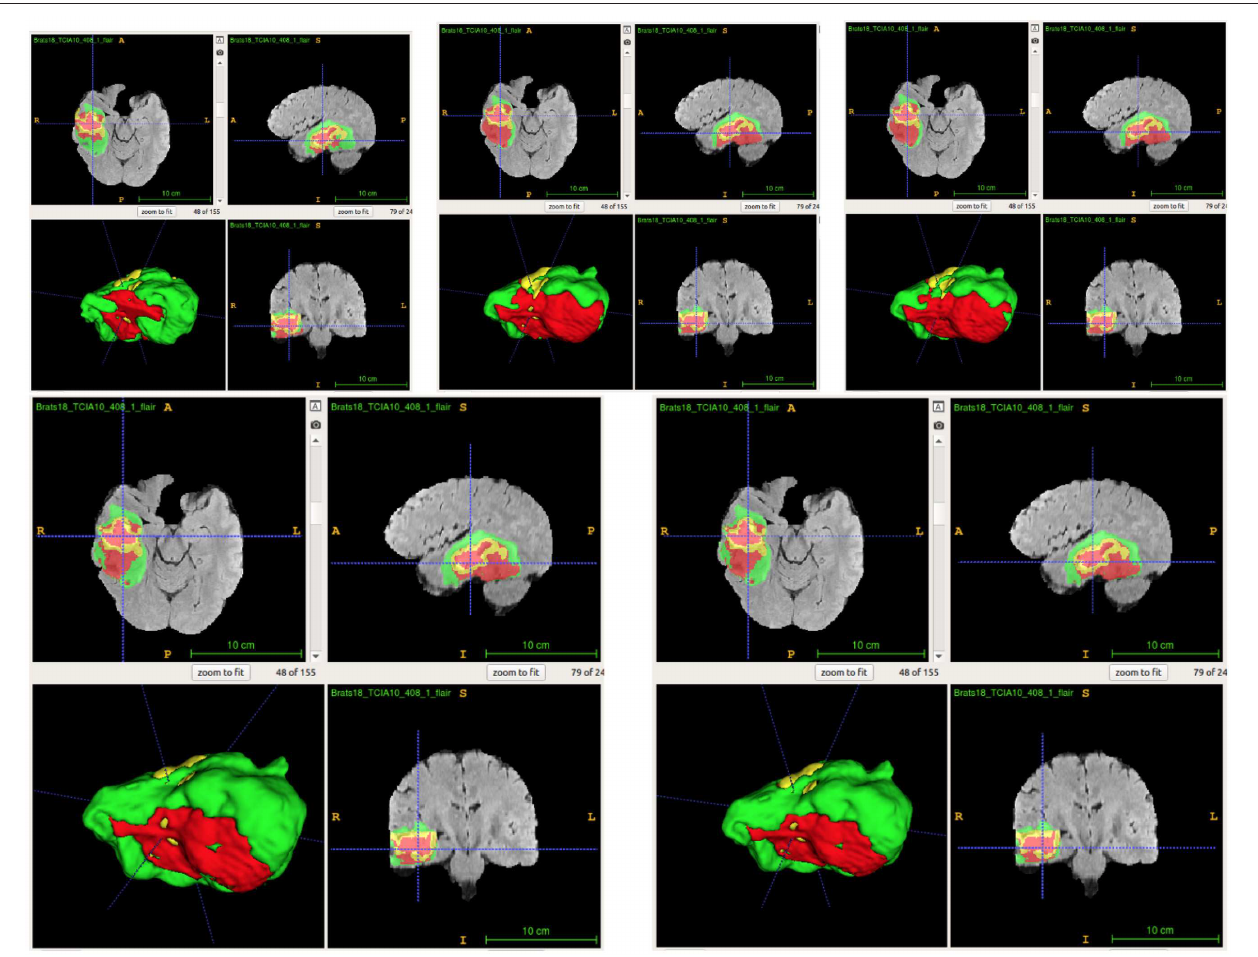
FIGURE 10 | Examples of predictions from different ensemble methods. The top left image shows the ground-truth lesion mask, and the top middle image shows the predictions using the arithmetic mean. The top right image shows the prediction using a two-level multi-class classification (TLMC) method. The bottom left image shows the prediction using a two-level binary classification (TLBC) method, and the bottom right image shows the prediction using a two-level fusion classification (TLFC) method. Red: enhancing tumor, yellow: necrosis & non-enhancing tumor, and green: edema. ITK-SNAP (Fedorov et al., 2012) is used to visualize the MR images and lesion